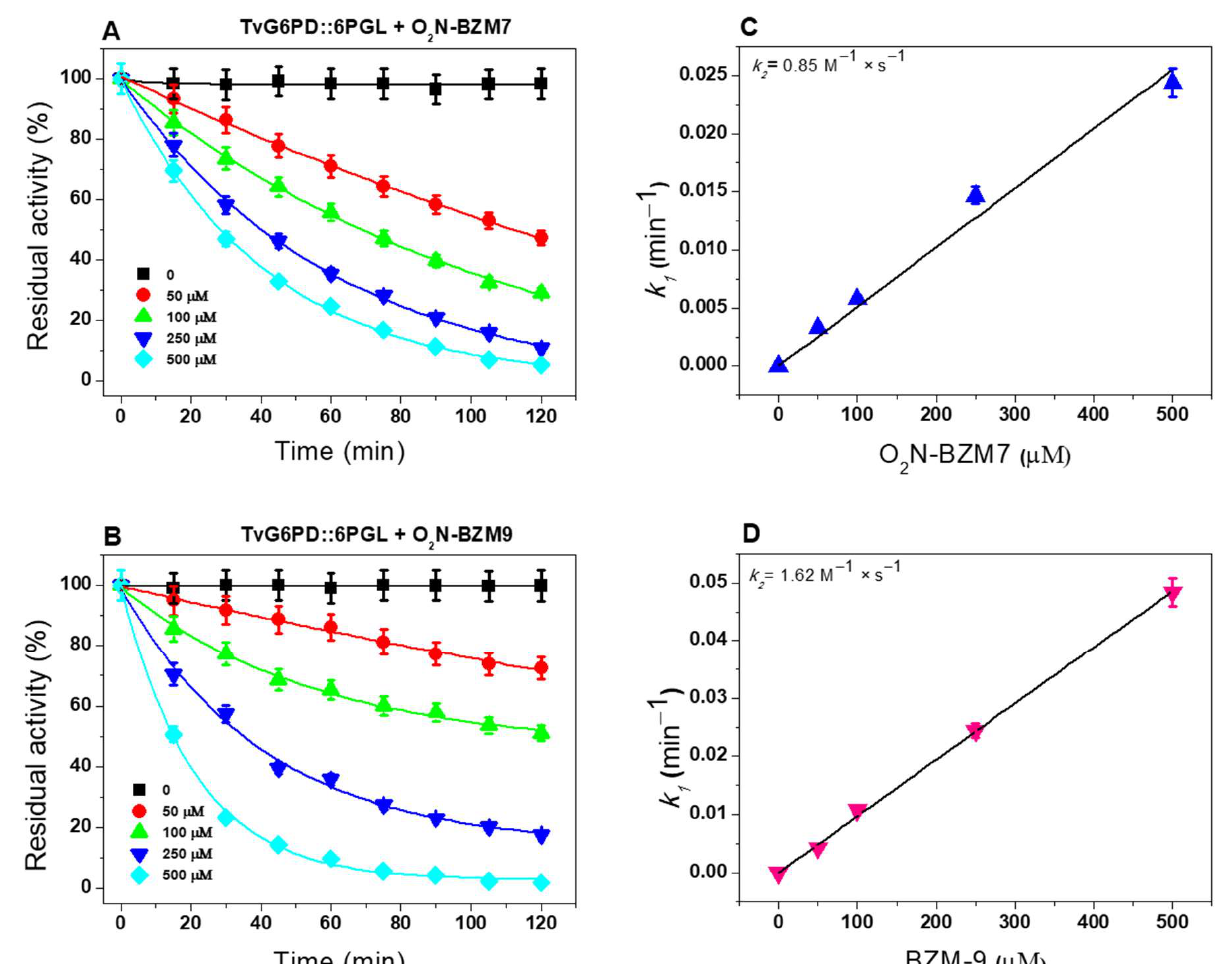
Figure 4. Inactivation assays of the enzyme G6PD::6PGL of T. vaginalis with O 2 N-BZM7 and O 2 N- BZM9 . ( A , B ) Pseudo-first-order rate constants ( k 1 ) for each compound were calculated by fitting the data to the exponential decay equation A R = A 0 e − kt , where A 0 is the initial activity value. ( C , D ) Second-order inactivation rate constants ( k 2 ) were obtained by plotting k 1 values against compound concentrations and fitted to a linear regression model. All experiments were performed in triplicate; standard errors were less than 5%. Table 2. Summary of inhibition, IC 50 values, and second-order rate constant values of inactivation ( k 2 ) of the compounds analyzed in this study.